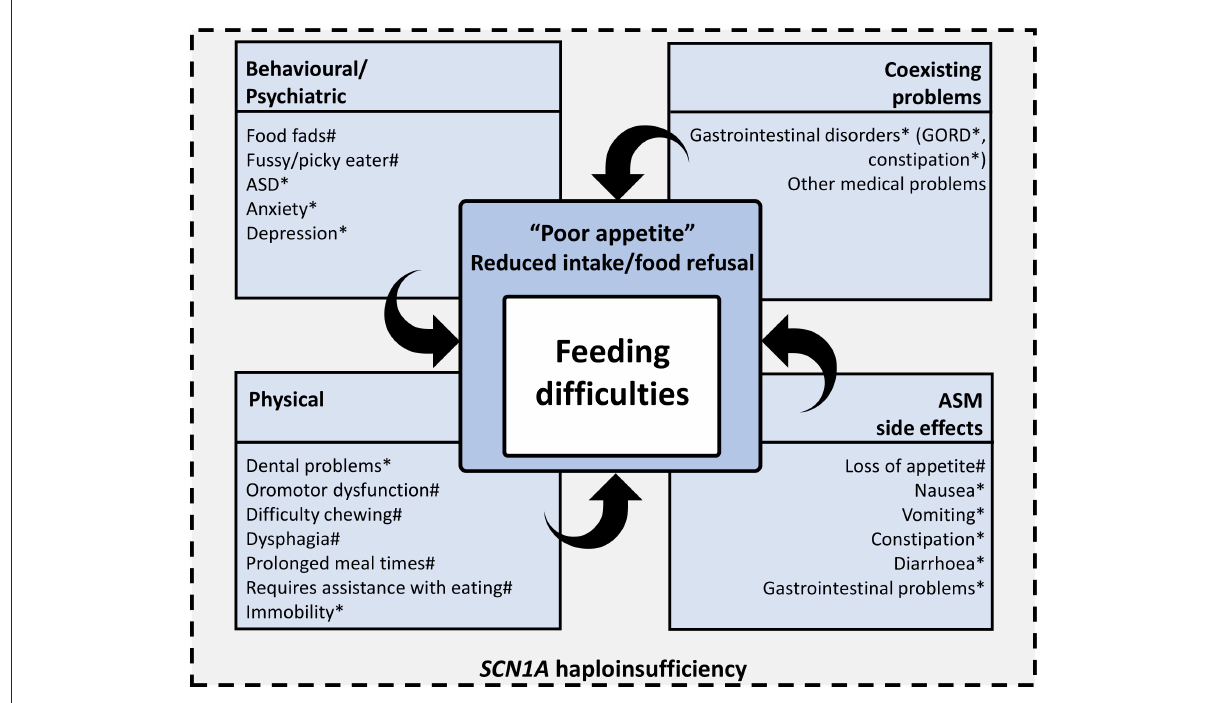
FIGURE2 Spectrum of potential feeding difficulties in people with DS. The true spectrum of feeding difficulties in people with DS are unknown and likely reflect a combination of physical, behavioral, medication, gastrointestinal and other medical problems. These issues may directly result in feeding difficulties (i.e., dysphagia) or may lead to reduced food intake/food refusal, which is observable to caregivers and clinicians as “poor appetite.” The underlying disease biology of DS ( SCN1A haploinsufficiency) may contribute to feeding difficulties through some of these factors. # = Feeding issue reported in caregiver surveys of people with DS, * = Problems reported in people with DS that may also contribute to feeding